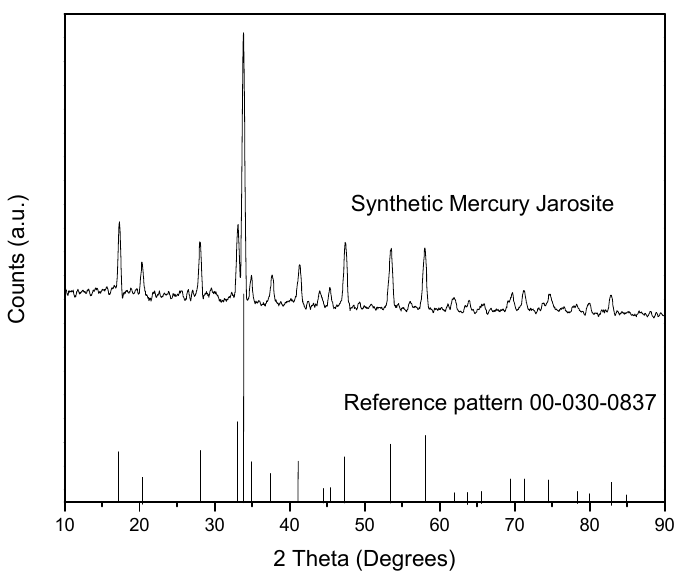
Figure 1. X-ray pattern corresponding to the synthesized solid; all of the reflections correspond to the synthetic mercury jarosite.